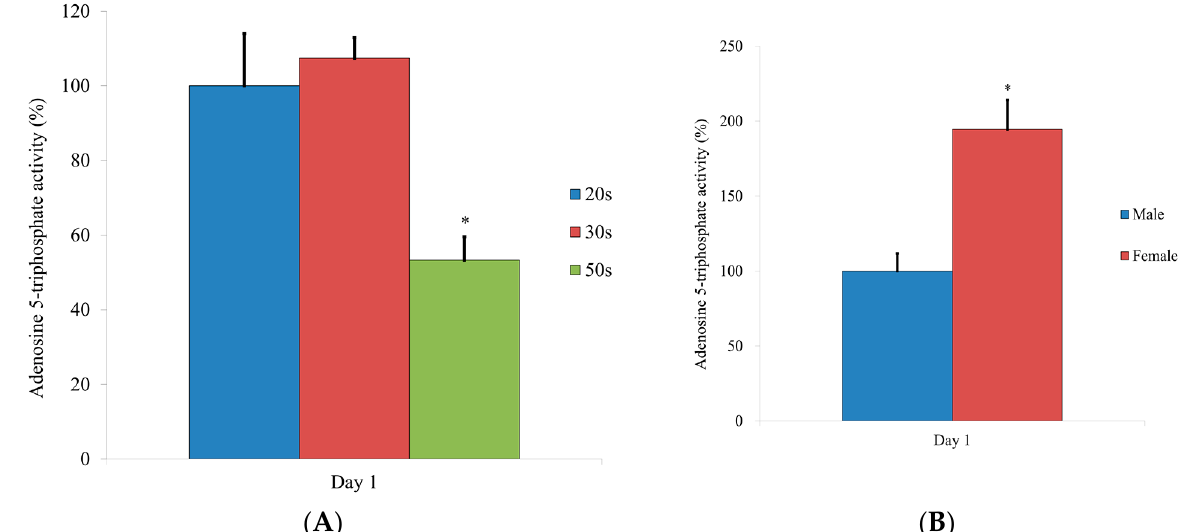
Figure 5. Results of the adenosine 5-triphosphate assay at Day 1. ( A ) Results from the different age groups. * Statistically significant differences were noted when compared with the results of the 20s group. ( B ) Results on Day 1 by sex. * Significant differences were noted when compared with the male group.